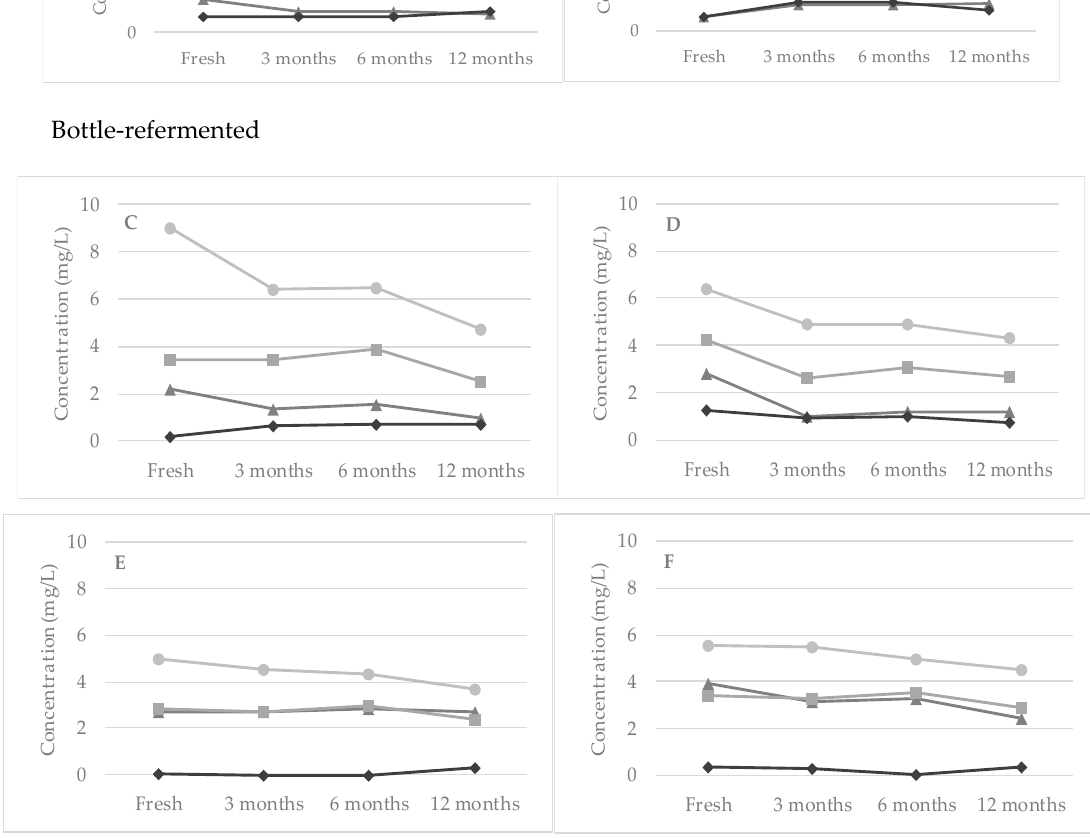
Figure 3. Concentrations (mg/L) of isovaleric acid ( ▲ ), hexanoic acid ( ■ ), octanoic acid ( ● ), and decanoic acid ( ♦ ) in fresh beers (A–F) and their evolution during natural aging (3, 6, and 12 months). Variation coefficients under 5%.